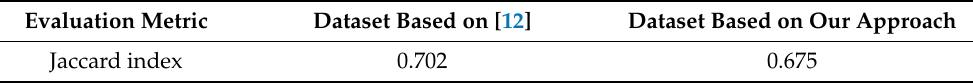
Table 5. Semantic segmentation results for datasets based on [12] and our